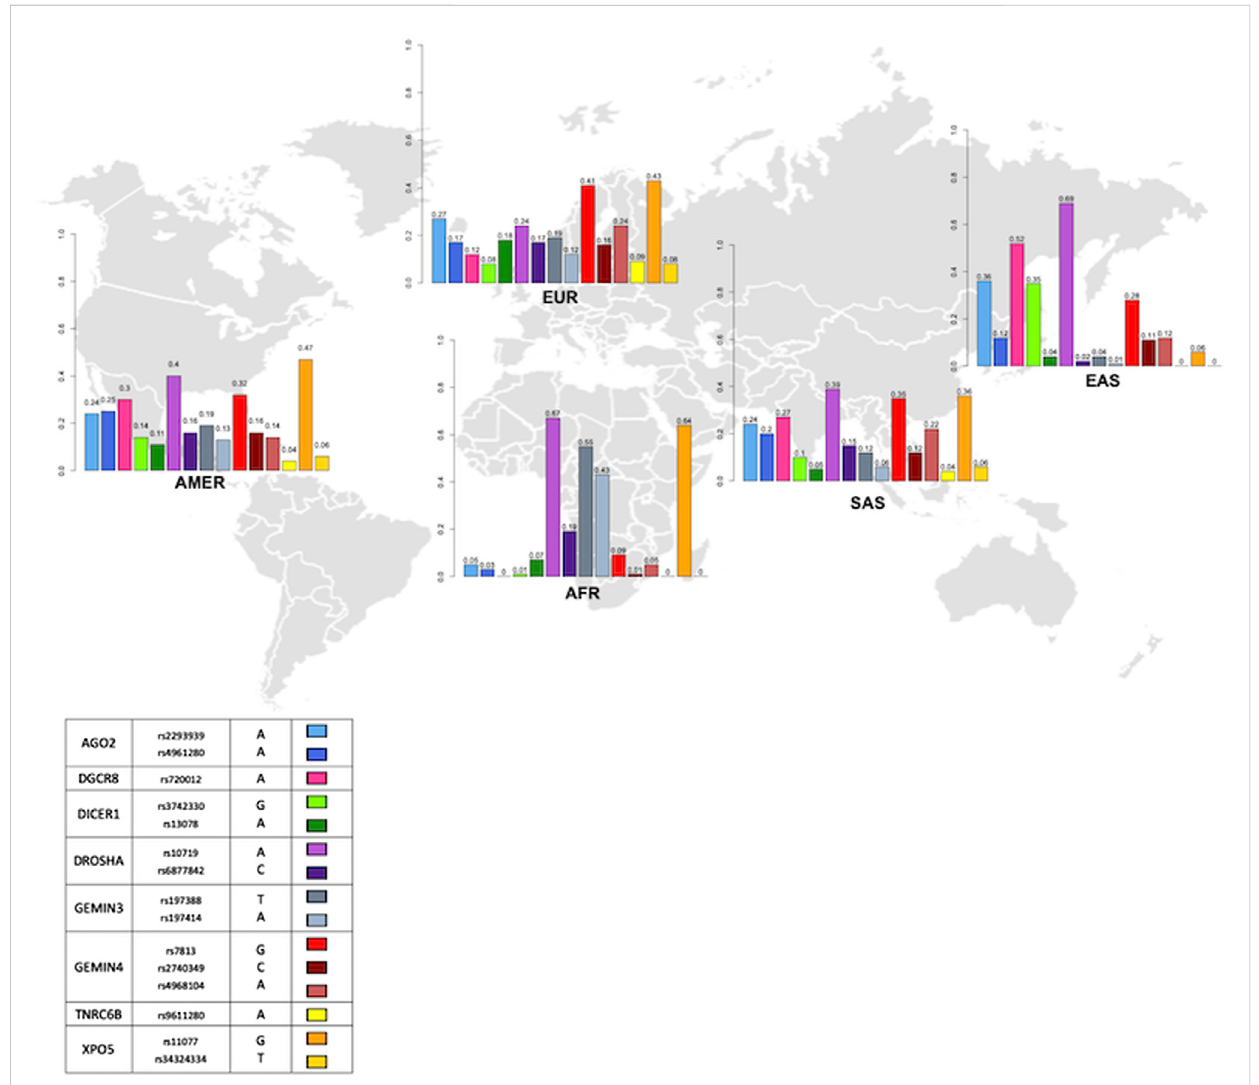
FIGURE 7 Worldwide distribution of the minor allele frequency of SNVs in components of the miRNA biosynthesis machinery in different sub-continental populations. Abbreviations in the fi gure are the same from Figure 1. Boxes in color denote each variant in the graphics. Numbers at the top of the bars in the graphics correspond to the minor allele